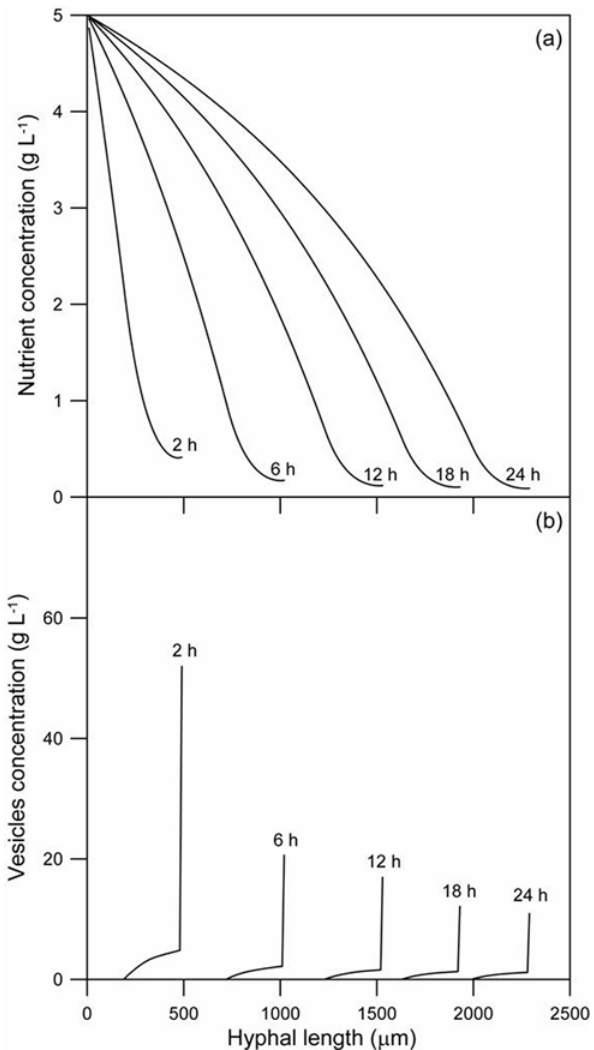
Fig 4. Model predictions for spatial profiles of nutrient and vesicles at different times for Rhizopus oligosporus . (A) Nutrient concentration; (B) Concentration of vesicles. The time of each spatial profile is indicated directly on the graph. The initial values of the variables and the parameter values are as listed in Table